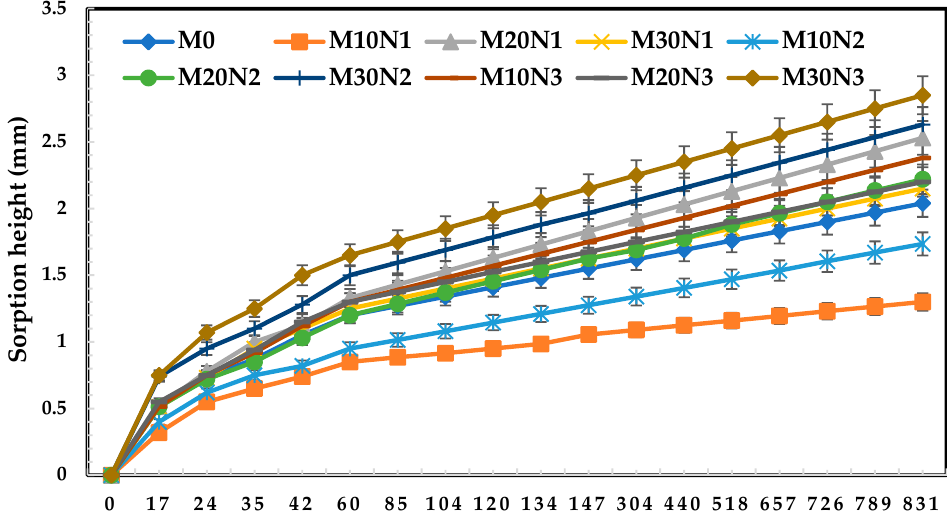
Figure 10. Water sorption of different concretes with and without POFA.